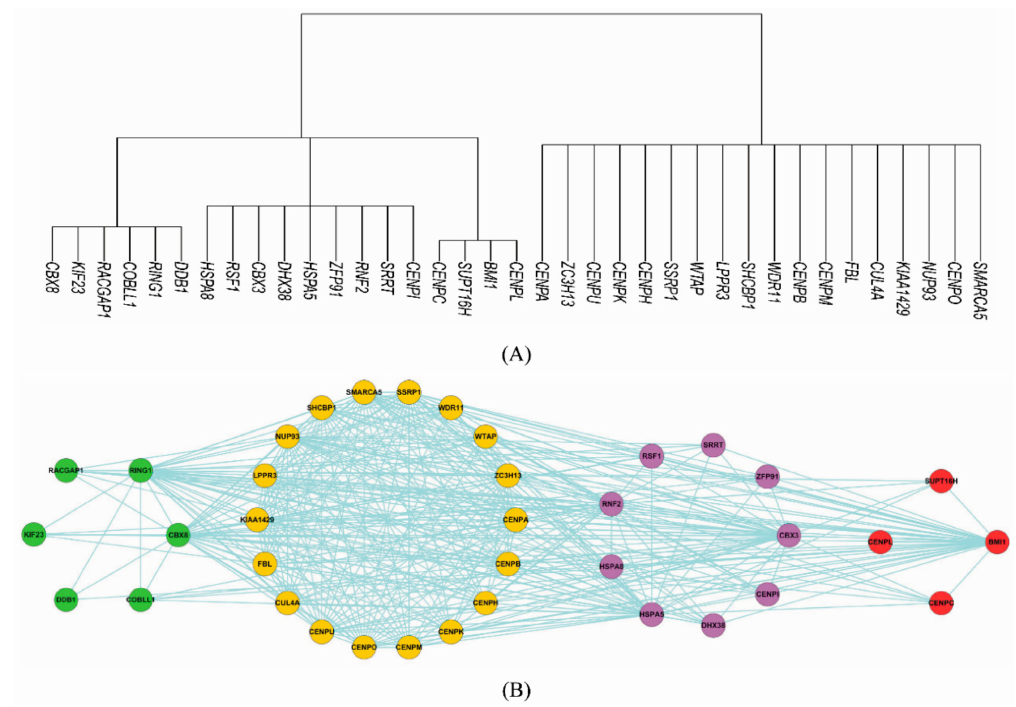
Figure 4. Inferred hierarchical sub-complexes via Matthews correlation coe ffi cient (MCC) graph clustering ( A ) and the inner topological visualization ( B ) within centromere chromatin (CEN) complex from CORUM [4] (37 subunits).